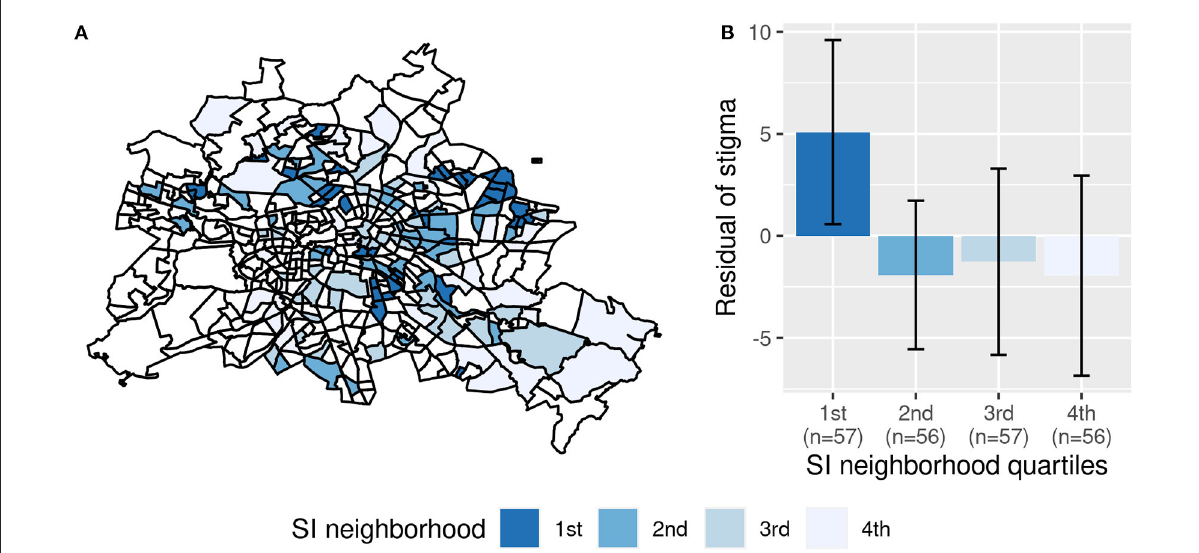
FIGURE2 Association between perceived stigma and social index of the neighborhood (“SI neighborhood”). (A) Shows Berlin with its 447 neighborhoods. White areas did not contain any patients from our sample. (B) Displays the mean residual stigma values of the quartiles of SI neighborhood with error bars representing 95% confidence intervals around the mean. The residuals are corrected for social index of the district, restrictions of daily life, unfavorable income and seizures in the past 6